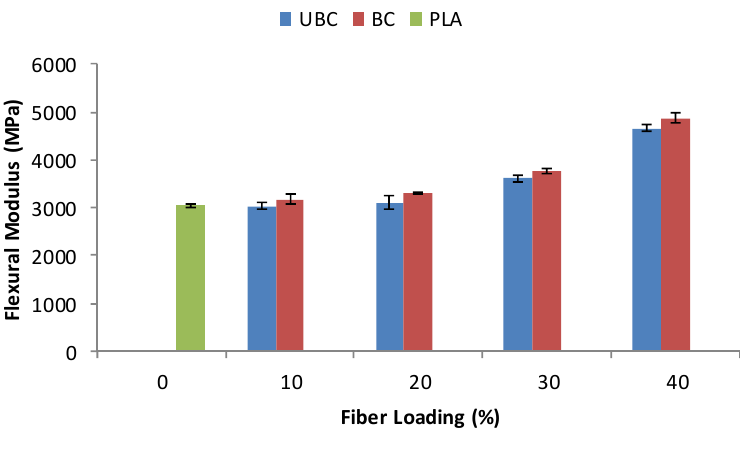
Figure 8. Flexural modulus of pure PLA, UBC and BC composites.